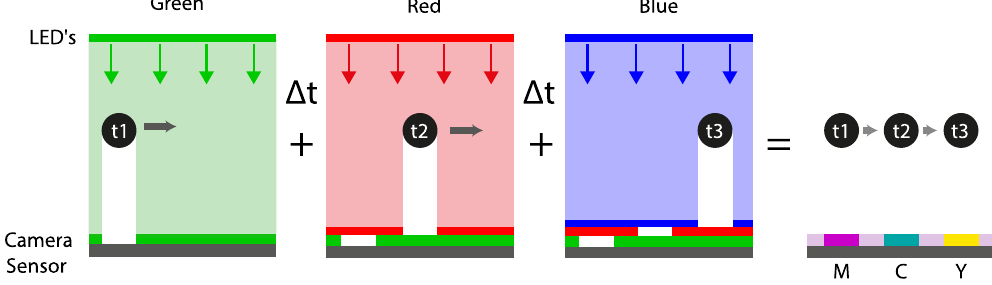
Figure 6. Schematic representation of the color time-coding approach used for the CMOS sensors. As the particle travels, the colored lights are flashed at different times, leaving their corresponding shadowed pixels recorded in the camera sensor. The final result is an image of the negative colors for each time step, i.e. green flash marks the particle location by magenta pixels, red by cyan and blue by